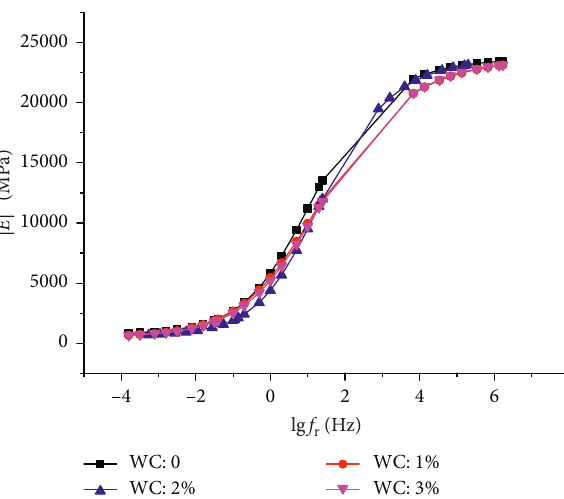
Figure 22: 90#AC-20-type dynamic modulus main curve.